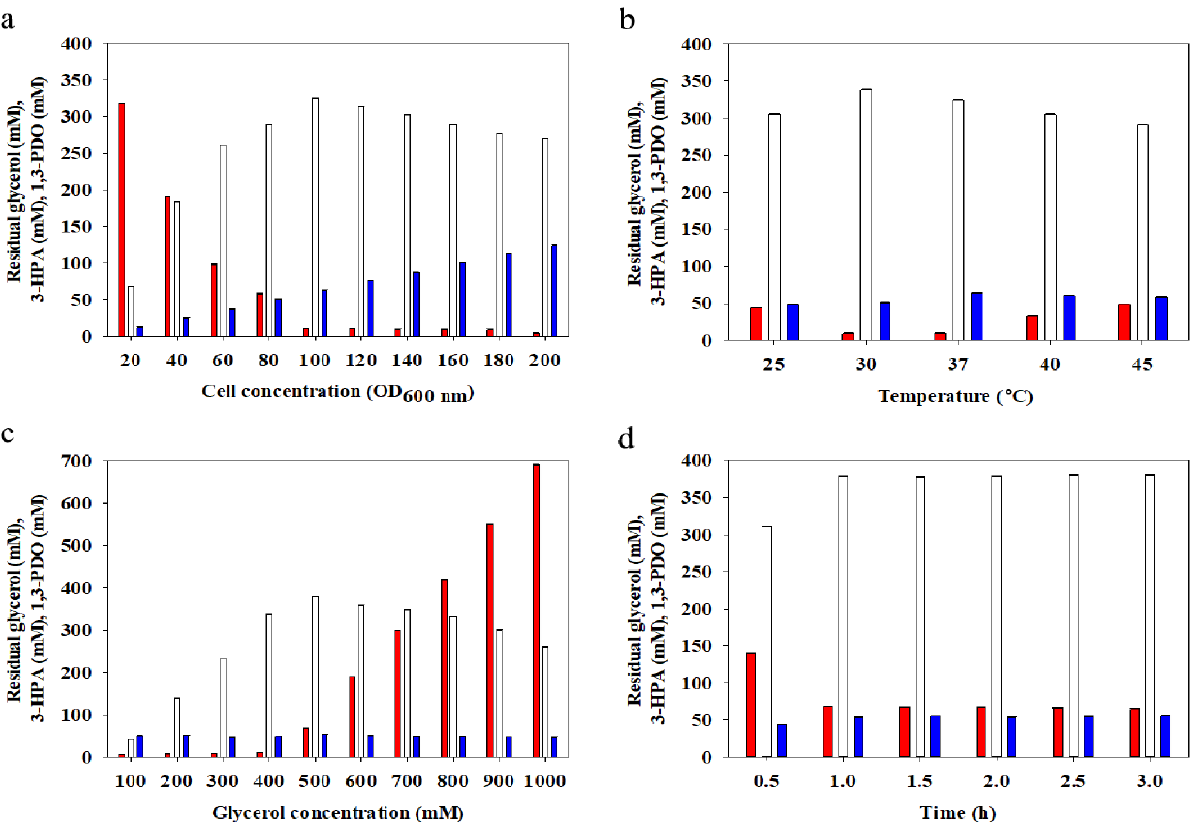
Figure 3. 3-hydroxypropionaldehyde bioconversion at a different cell density ( a ), bioconversion temperatures ( b ), glycerol concentrations ( c ), and bioconversion times ( d ). Red bars, residual glycerol; white bars, 3-hydroxypropionaldehyde; blue bars, 1,3-propanediol. All results are averages from three independent experiments.